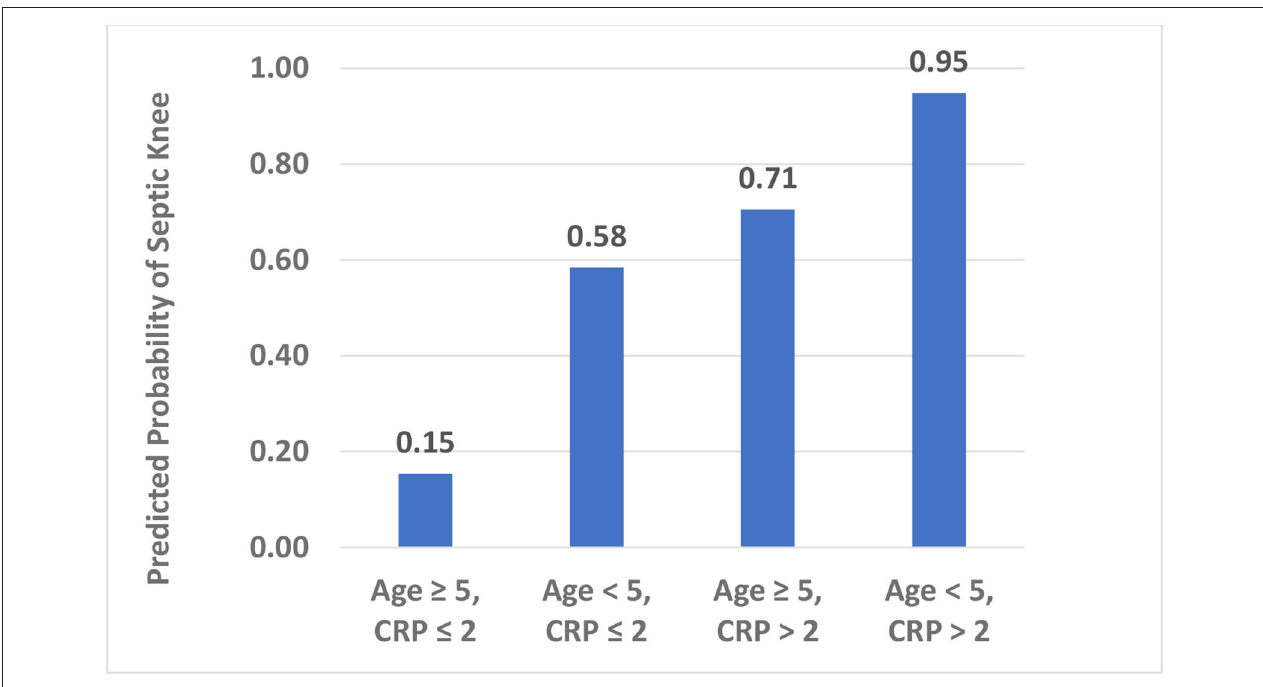
FIGURE 2 | Predicted probability of a septic knee by age (years) and CRP (mg/dl).